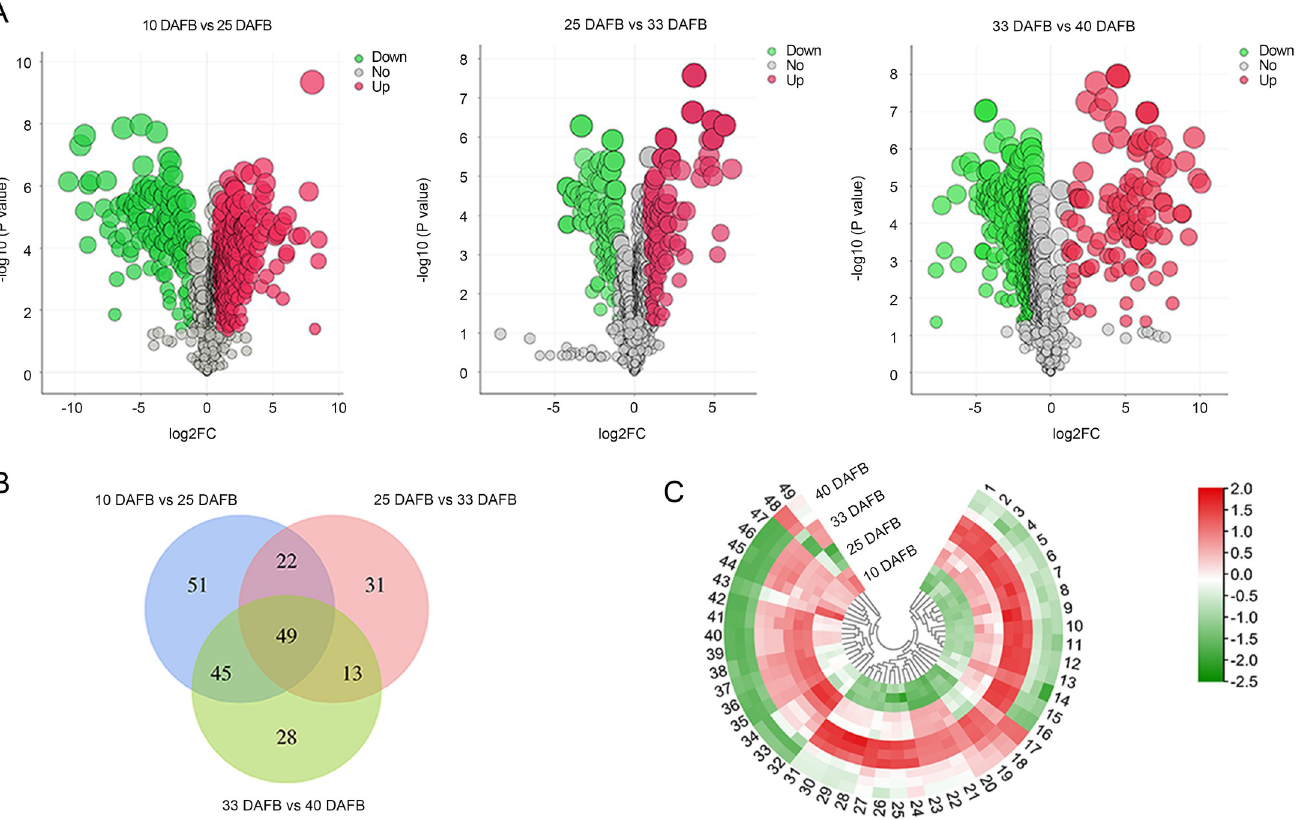
Fig 3. Differentially accumulated metabolites in sweet cherry at different fruit development stages. (A) Volcano plots of differential metabolites in 10 vs. 25 DAFB, 25 vs. 33 DAFB, and 33 vs. 40 DAFB, respectively. (B) Venn diagram of DEMs in 10 vs. 25 DAFB, 25 vs. 33 DAFB, and 33 vs. 40 DAFB. (C) Heatmap of 49 DEMs obtained from intersection of 10 vs. 25 DAFB, 25 vs. 33 DAFB, and 33 vs. 40 DAFB.